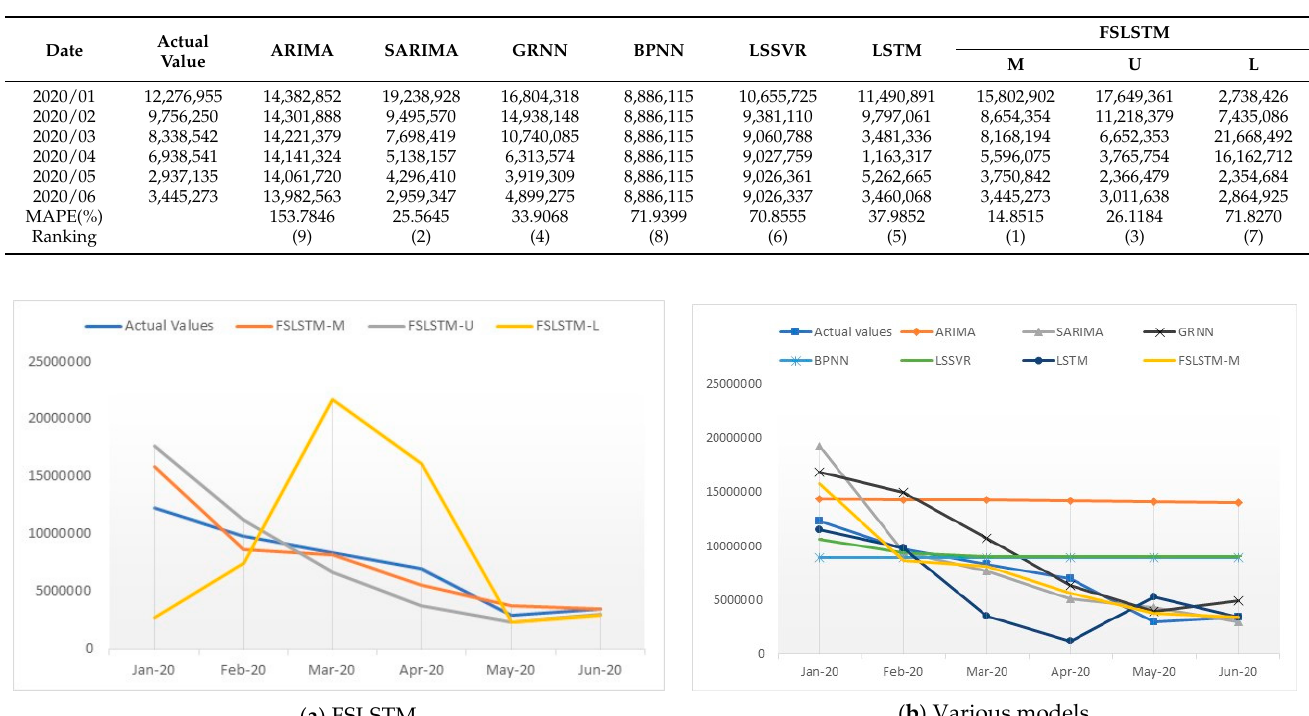
Table 7. Comparison of the forecasting results for the Mailiao wind power plant.